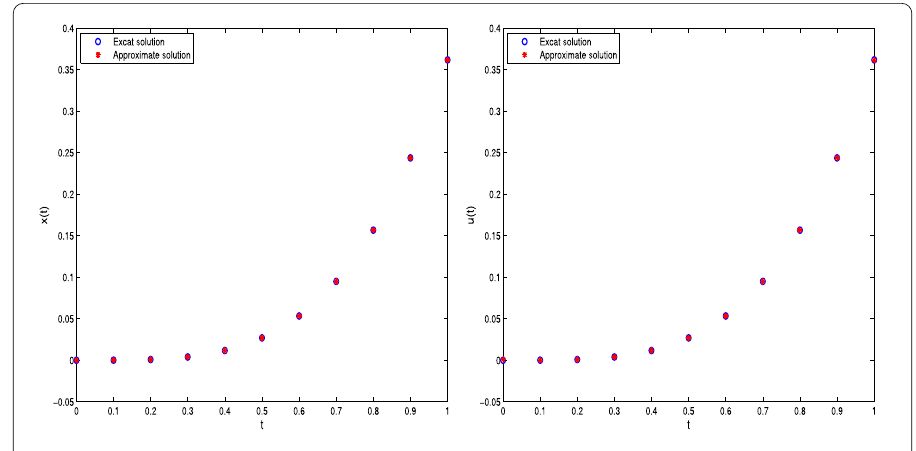
Figure 6 Exact and numerical solutions of x ( t ) and u ( t ) at ρ = 1.5, α = 0.5, and N =